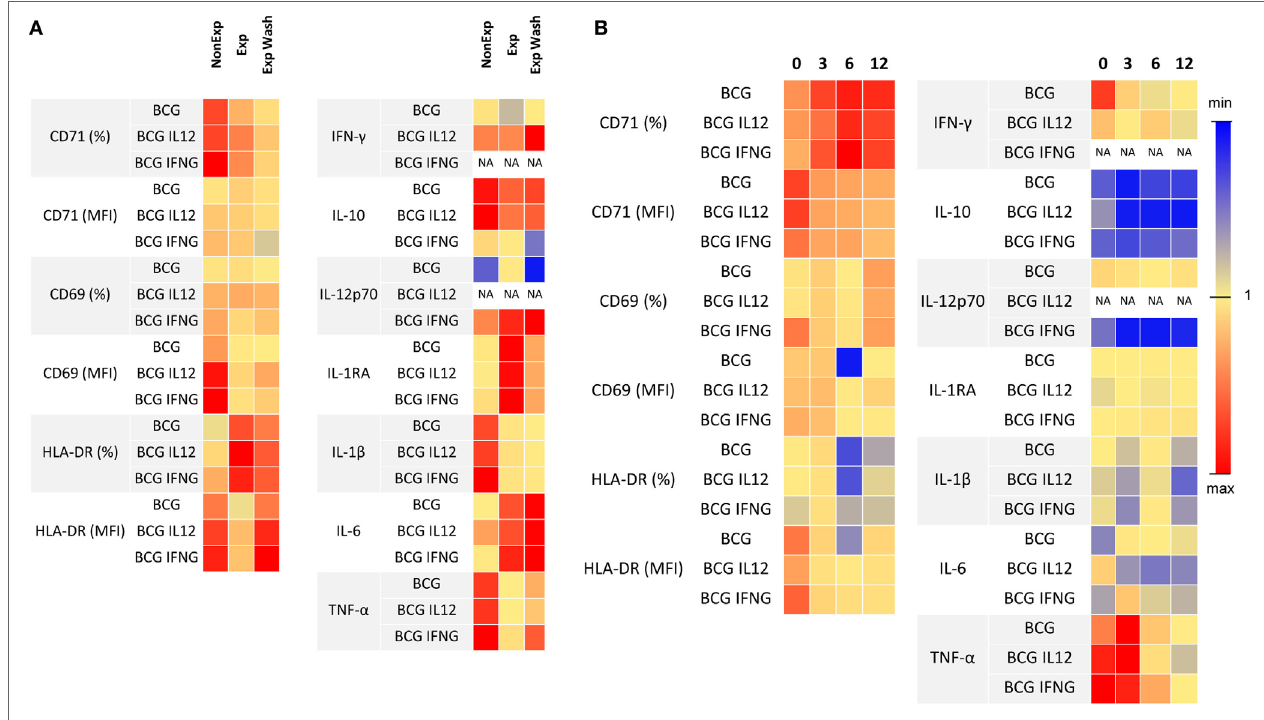
FigUre 5 | Effects of anti-TNF- α exposure in the IL-12/IFN- γ pathway. (a) Stimulation ratio of lymphocyte activation markers expression (measured with flow cytometry) and secreted cytokines (measured with luminex) is represented as a heat map. Stimulation ratio is calculated as “stimulated culture condition/baseline condition.” (B) Ratio of lymphocyte activation markers expression and secreted cytokines after Bacillus Calmette–Guérin (BCG) culture using washed blood and non-washed blood during follow-up is represented as a heat map. Blue indicates the minimum values, red the maximum, and yellow next to one for each parameter. Adalimumab-exposed infants, n = 4; infliximab-exposed infants, n =